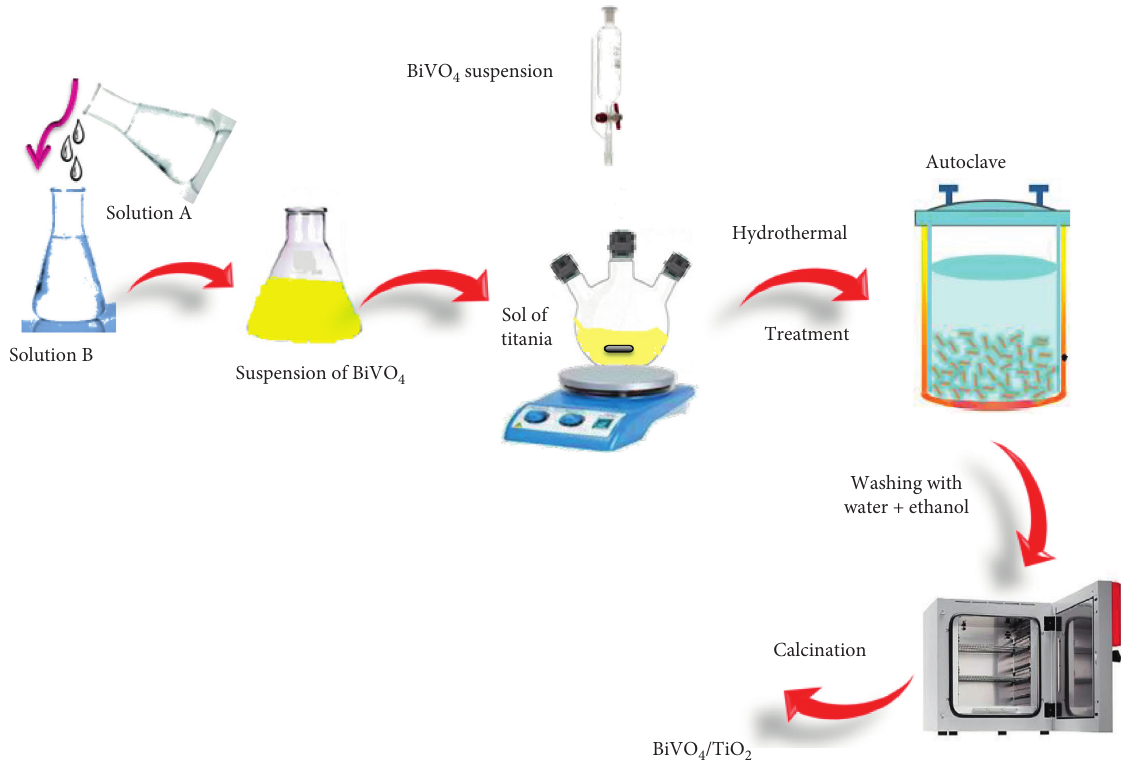
Figure 1: Experimental protocol of BiVO